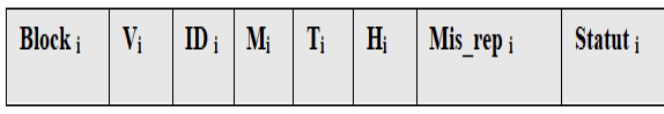
FIGURE 3. PROPOSED PACKET STRUCTURE WITH BLOCKCHAIN INTEGRATION